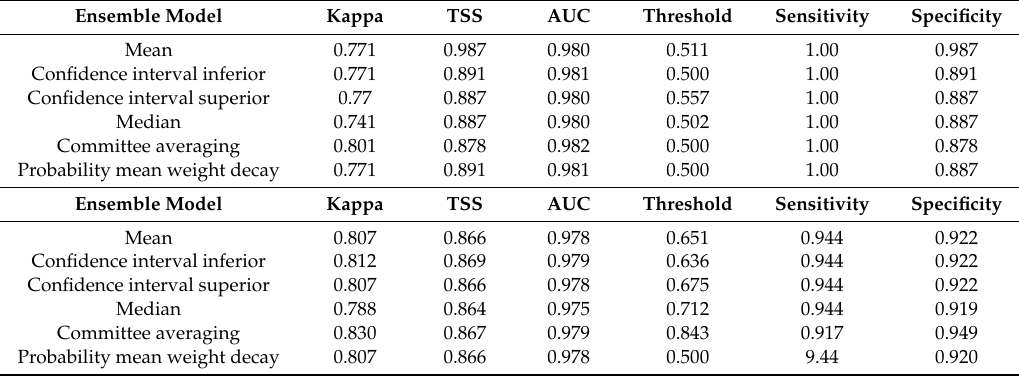
Table 3. Statistics of the fitted values obtained with the ensemble model for the prediction of habitat for Eucalyptus dunnii (top) and E. grandis (bottom) in